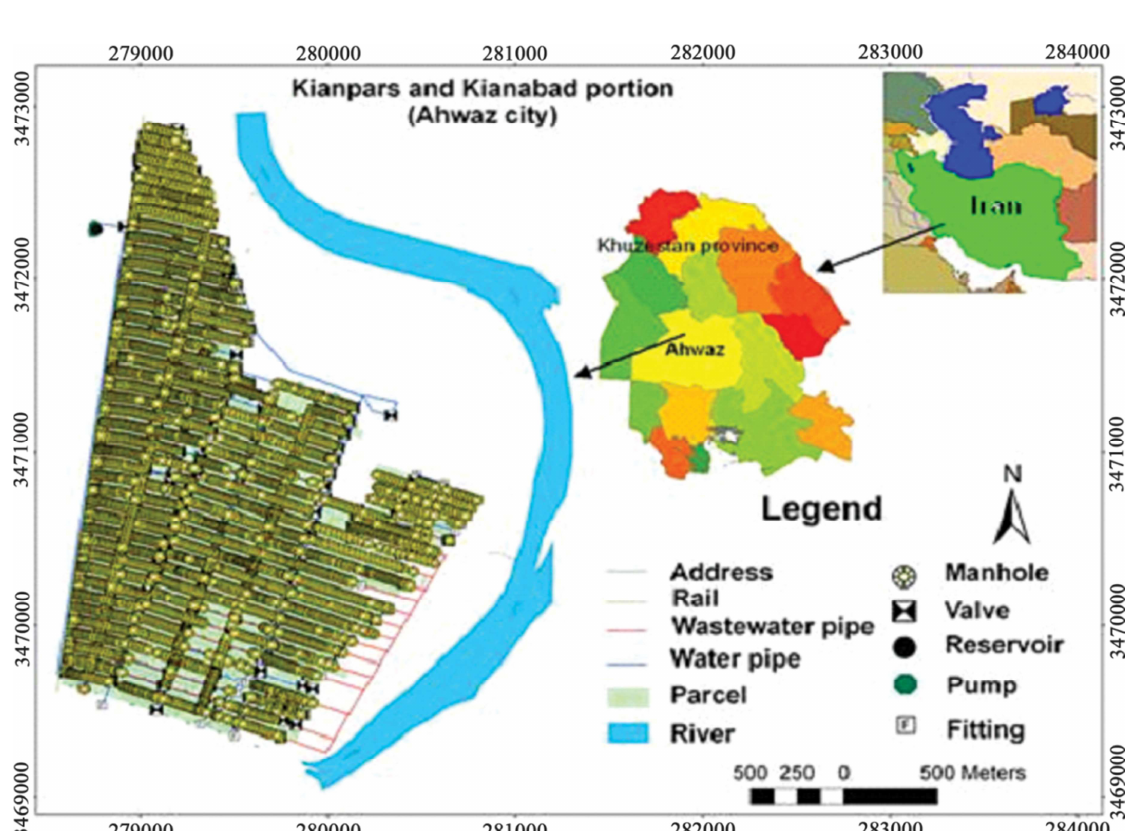
Figure 1. Study site location in the Ahvaz Water Distribution Network, in the south west of Iran21